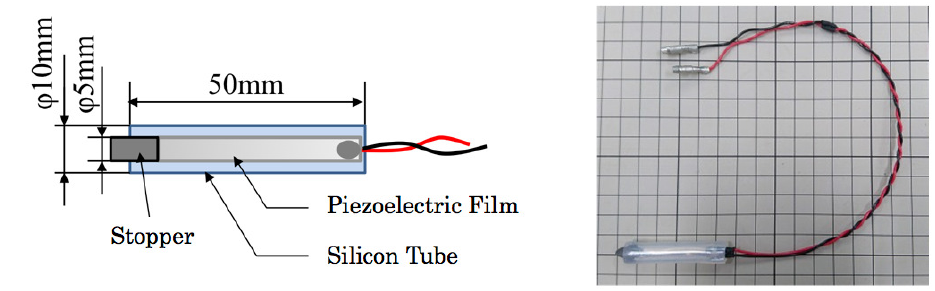
Figure 3. Interior architecture and appearance of the rail